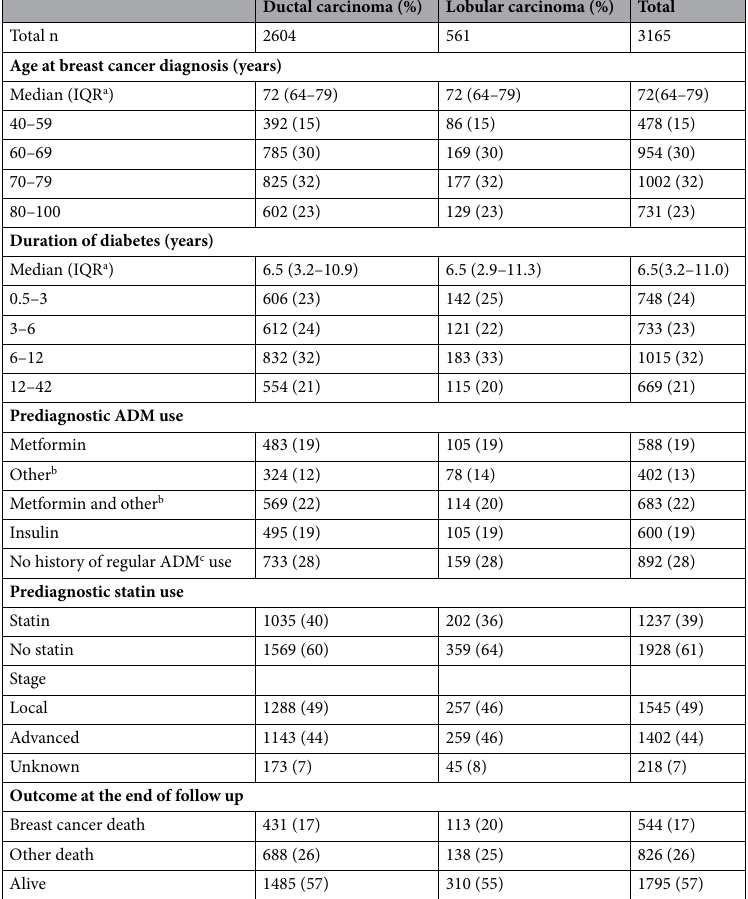
Table 1. Distribution of baseline characteristics and outcome status in ductal and lobular carcinoma. a Interquartile range. b Other oral antidiabetic medication. c Antidiabetic